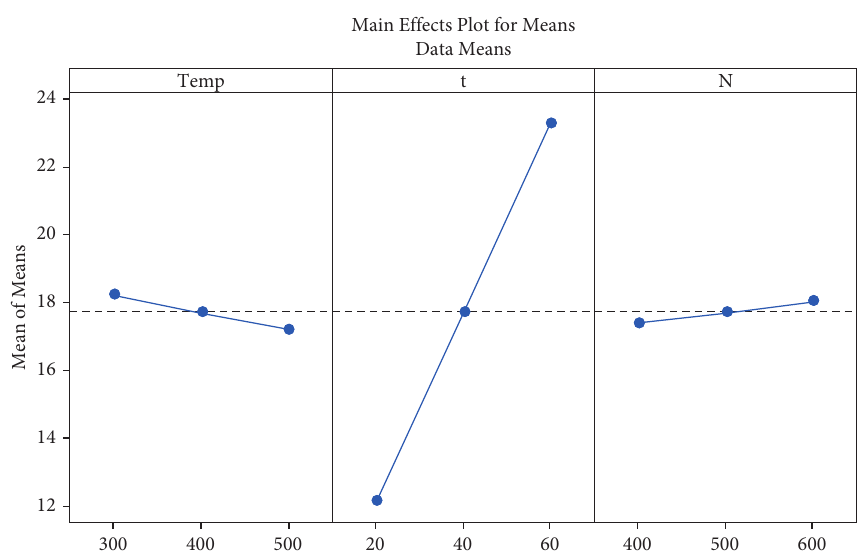
Figure 3: Significant consequence diagram based on means for porosity (temp: temperature in ° C; t : time in sec; N : stir speed in